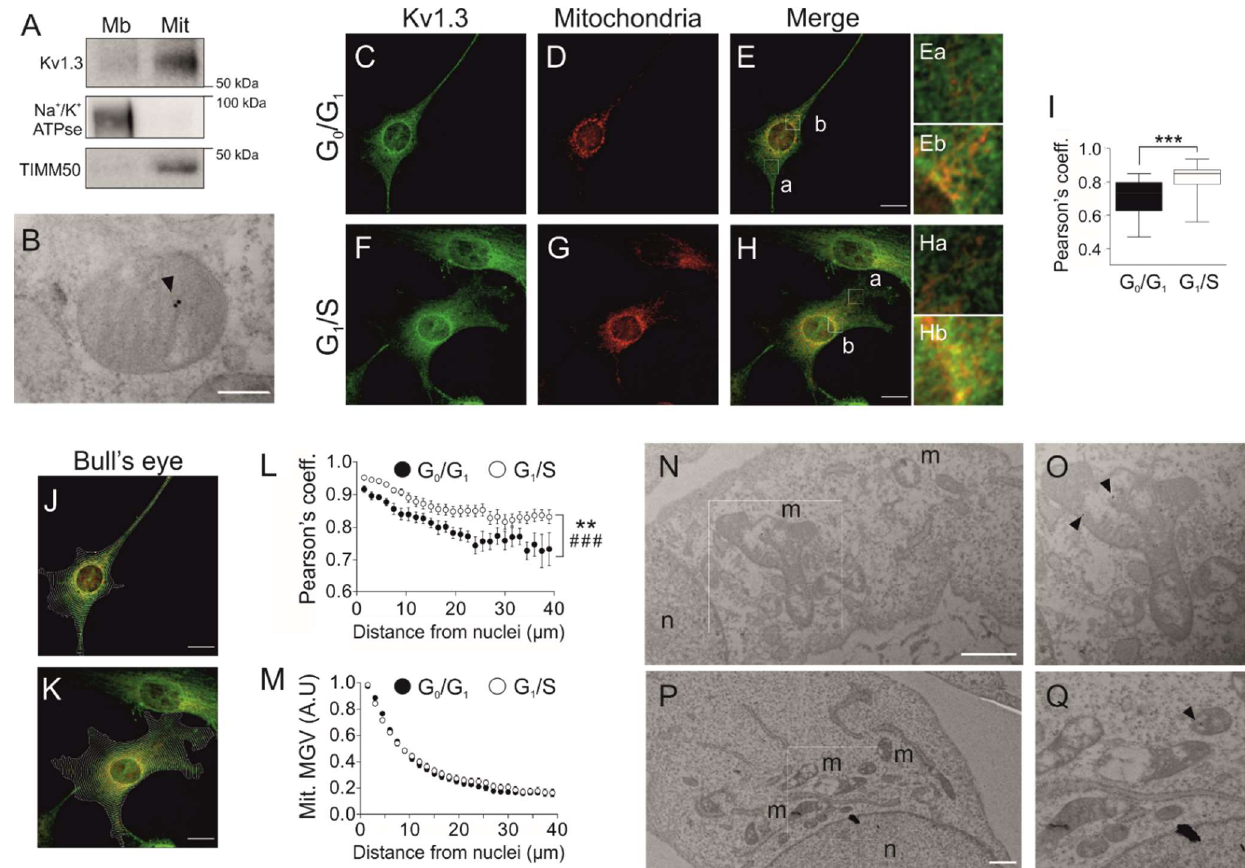
Figure 3. Kv1.3 accumulates at perinuclear mitochondria during the G1/S transition. ( A ) Subcellular fractionation of 3T3-L1 wild-type preadipocytes to obtain the membranous (Mb) and mitochondrial (Mit) fractions. The samples were probed for Kv1.3, Na+/K+ ATPase (a membrane marker) and TIMM50 (a mitochondrial marker). ( B ) Electron micrograph showing mitochondria of 3T3-L1 wild-type preadipocytes. Kv1.3 was labeled with 18 nm immunogold particles (black arrowhead) and was located at the inner mitochondrial membrane. The scale bar represents 200 nm. ( C – H ) Cells were either in the G0/G1 or the G1/S phase following serum deprivation or serum readdition for 12 h, respectively. Representative confocal images showing Kv1.3 and mitochondria in wild-type preadipocytes fixed in the G0/G1 ( C – E ) and G1/S ( F – H ) phase. Ea-Eb and Ha-Hb are magnified images of E and H, respectively. Ea and Ha show distal regions, and Eb and Hb show perinuclear regions. Yellow indicates colocalization of Kv1.3 (green) and mitochondria (red). The scale bar represents 20 µ m. ( I ) Pearson’s coefficient of colocalization between Kv1.3 and mitochondria. The data are the mean ± SE ( n > 30). *** p < 0.001. ( J , K ) Bull’s eye analysis of the images in panels C–E and F–H. Equally spaced concentric rings of the shape of the nucleus covering the whole cell were automatically drawn. Yellow indicates colocalization between Kv1.3 (green) and mitochondria (red). ( L ) Analysis of Kv1.3 and mitochondrial colocalization. Pearson’s coefficient was measured for each ring and plotted against the distance from the nucleus. The data are the mean ± SE ( n > 30 cells). ** p < 0.01 (G0/G1 vs. G1/S); ###, p < 0.001 (vs. distance from the nucleus) (two-way ANOVA). ( M ) Analysis of mitochondrial perinuclear distribution. The mean gray value (MGV) of the mitochondrial marker was measured for each ring and plotted against the distance from the nucleus. The data are the mean ± SE ( n > 60). ( N – Q ) Electron micrographs of cells show Kv1.3 labeled with 18 nm immunogold particles (black arrowheads). The square insets are magnified images of O and Q. n, nuclei. m, mitochondria. The scale bar represents 1 µ